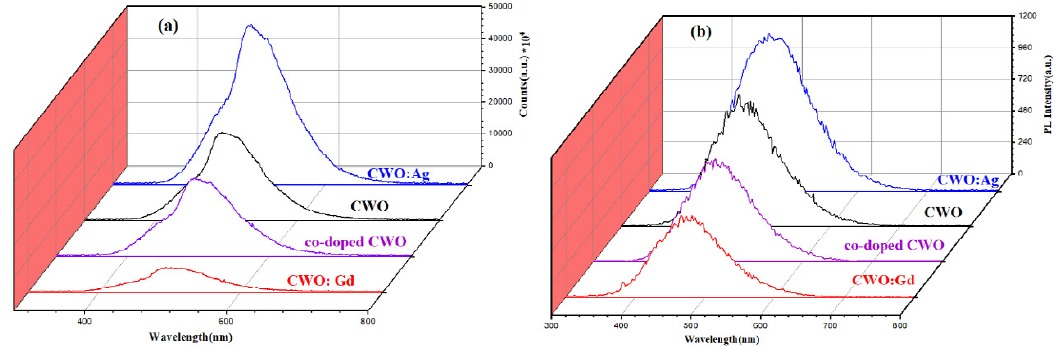
Figure 5. (a)IBIL and (b)PL spectra of CWO, CWO: Gd, CWO: Ag, and co-doped CWO nanopowders at room temperature.